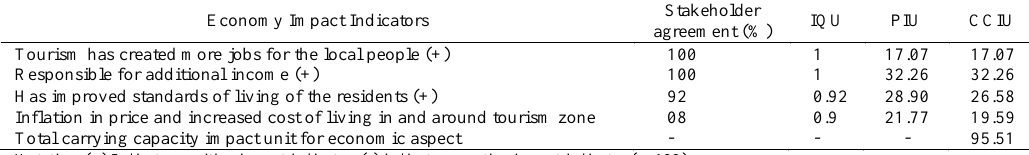
Table 7: Indicator quality unit and carrying capacity impact unit of economic carrying capacity